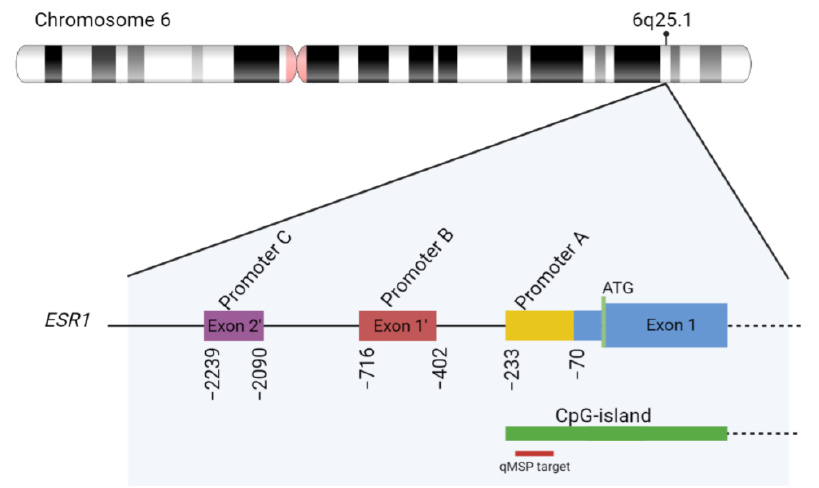
Figure 4. ESR1 exon 1 and positions of ESR1 promoter regions, based on the RefSeq curated ESR1 sequence. The genomic coordinates are relative to the ESR1 startcodon located at chr6:151,807,913 (hg38 reference genome). The red line indicates the location of the qMSP that was used to evaluate the ESR1 methylation status in cohorts 1 and 2.